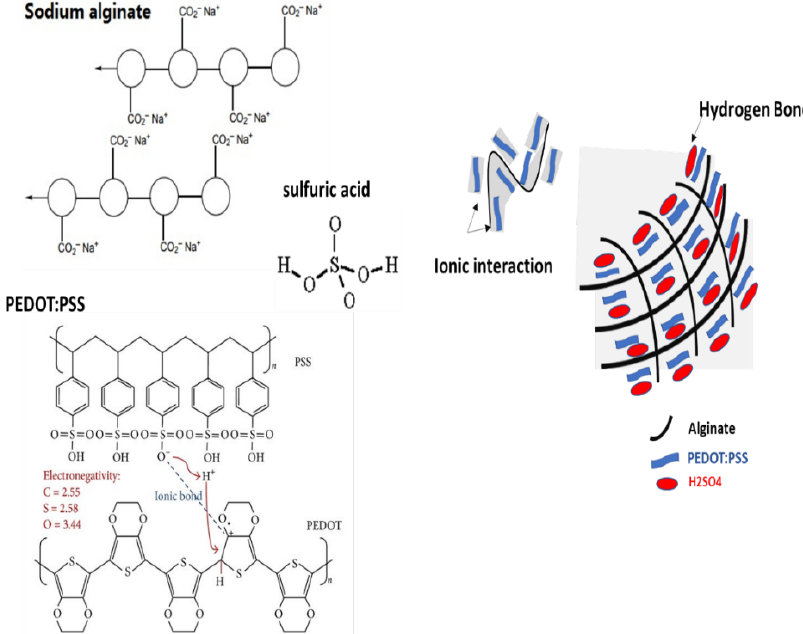
Figure 1. Schematic illustration of mixed ionic and electronic conduction in composite hydrogel electrolyte.